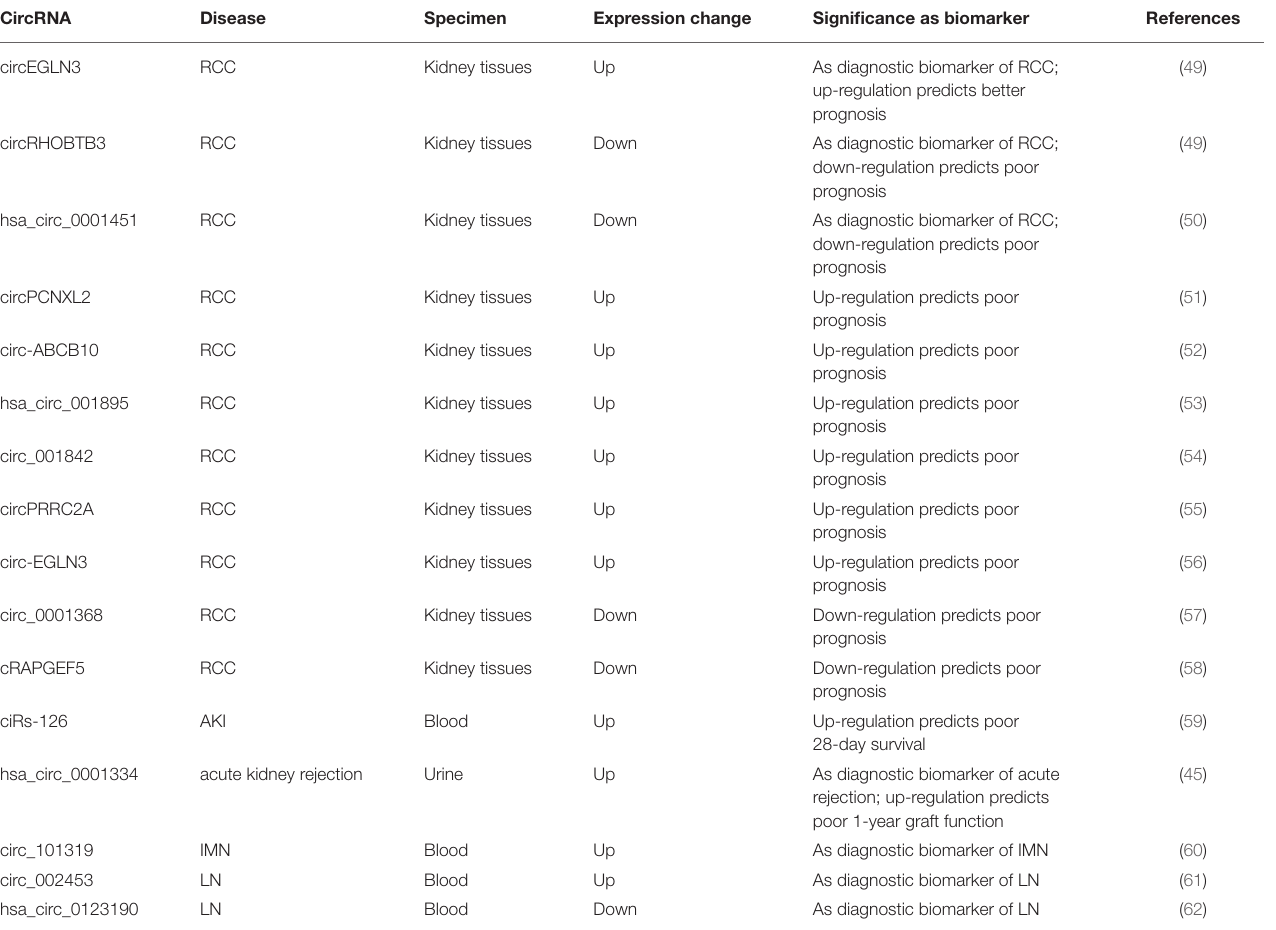
TABLE 1 | Summary of candidate circRNAs as biomarkers in kidney diseases.